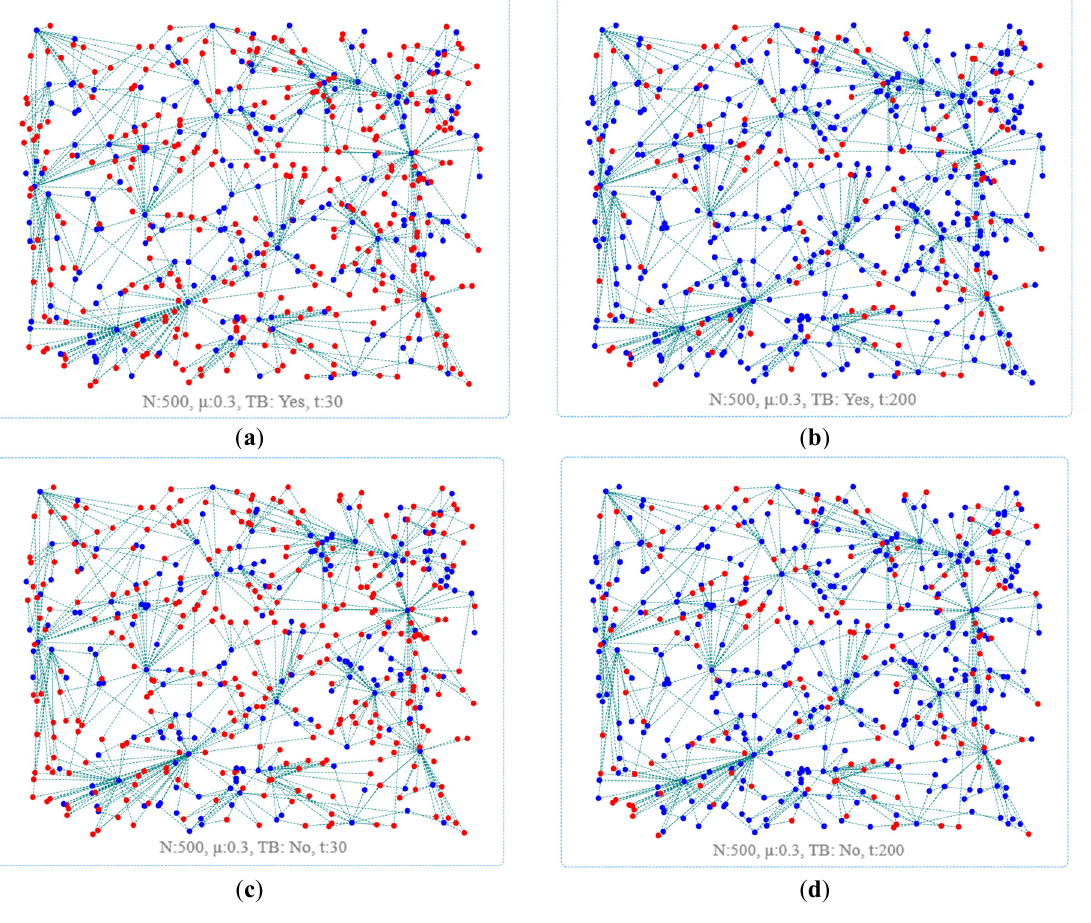
Figure 5. Influence of CID on BCW under trust boundary (number of firms = 500). Note: the red node means normal bidders, the blue node means collusive bidders, and the node’s size represents the degree of the node.